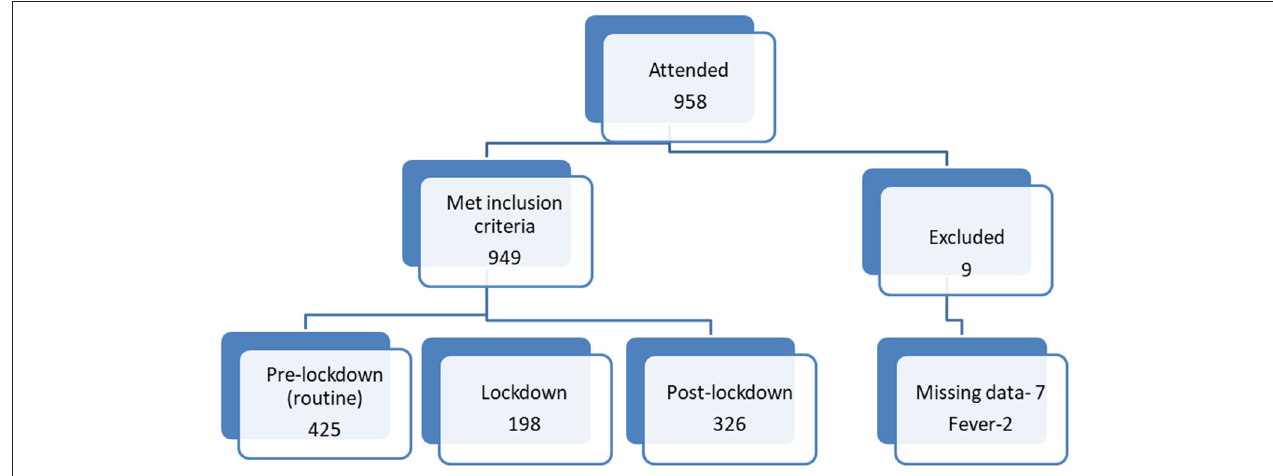
FIGURE 1 | Patient allocation flow